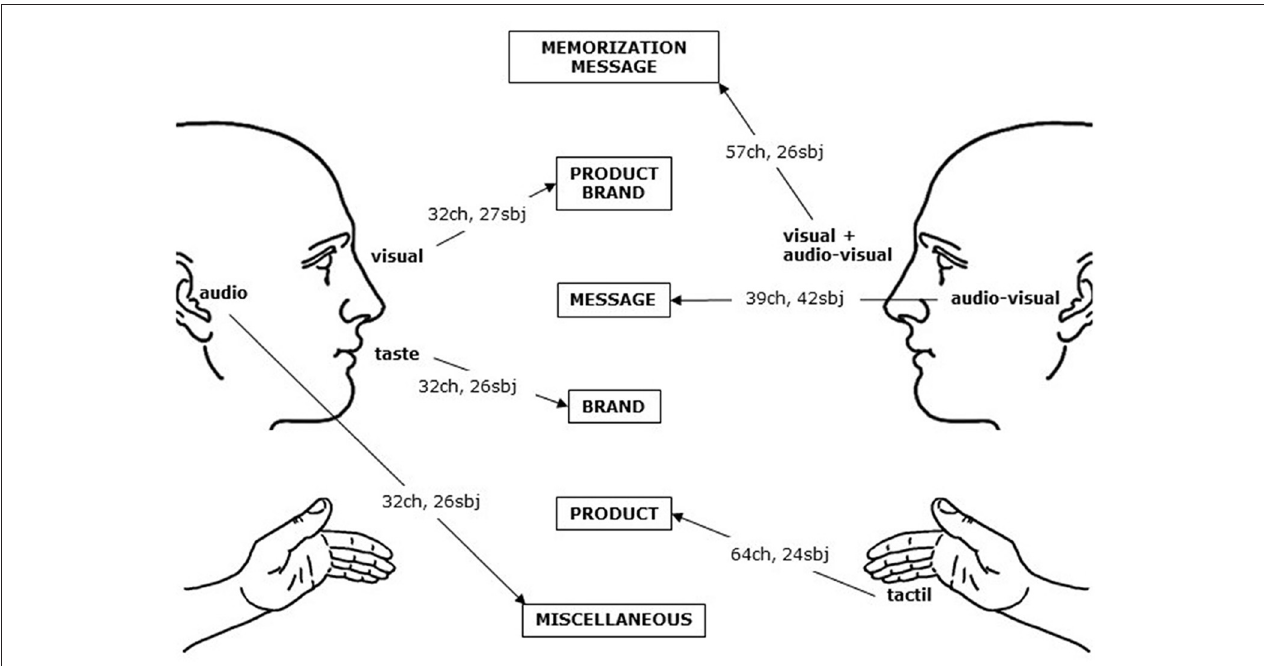
FIGURE 6 | Average number of participants and EEG channels in the reviewed studies, grouped by stimulus category, and most frequent research topics for each category. Visual indicates static visual stimuli (e.g., picture), audiovisual indicates dynamic stimuli (e.g.,